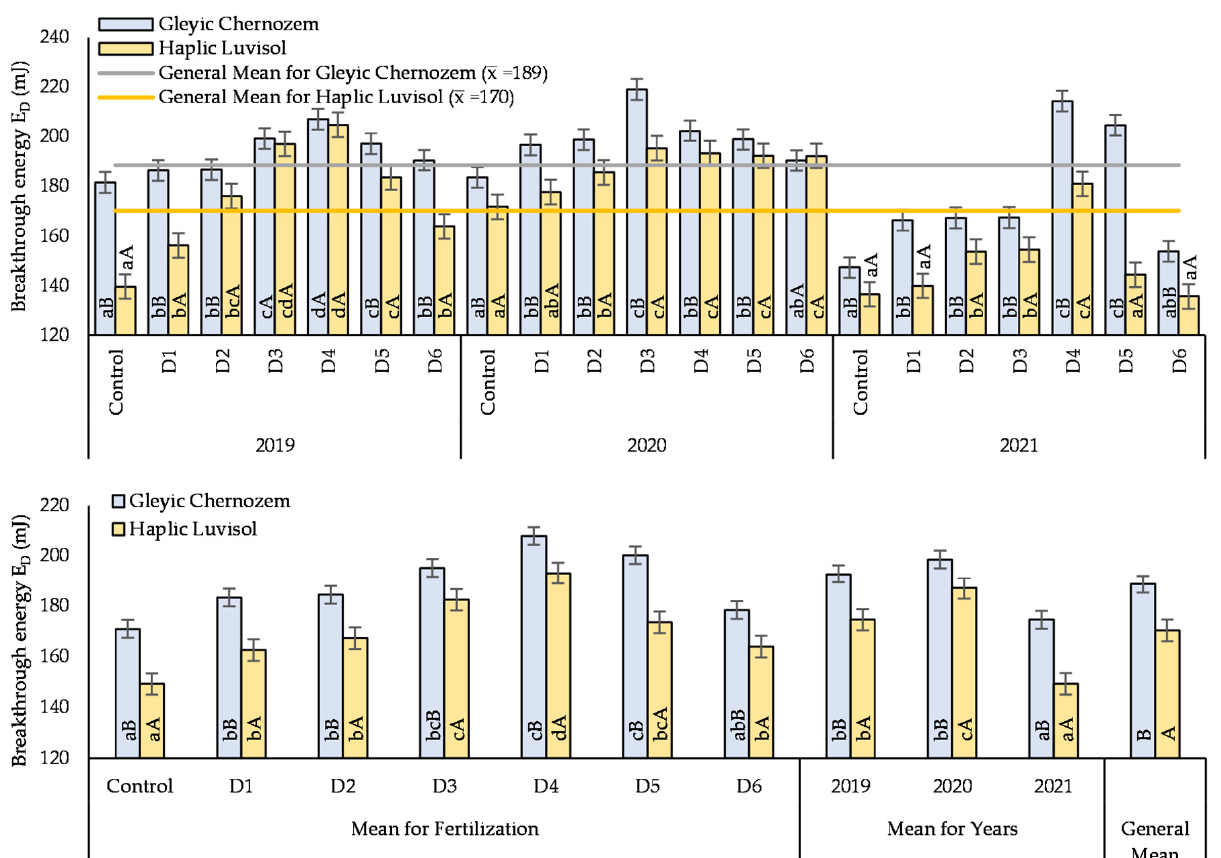
Figure 6. Average values of the breakthrough energy E D (mJ) depending on the type of soil, fertiliser applied and year of research. Statistical data are expressed as mean ± SD values. Different letters show significant differences ( p < 0.05) according to Tukey’s range test. Capital letters mean differences between particular types of soil, small letters mean differences between particular doses of fertiliser.